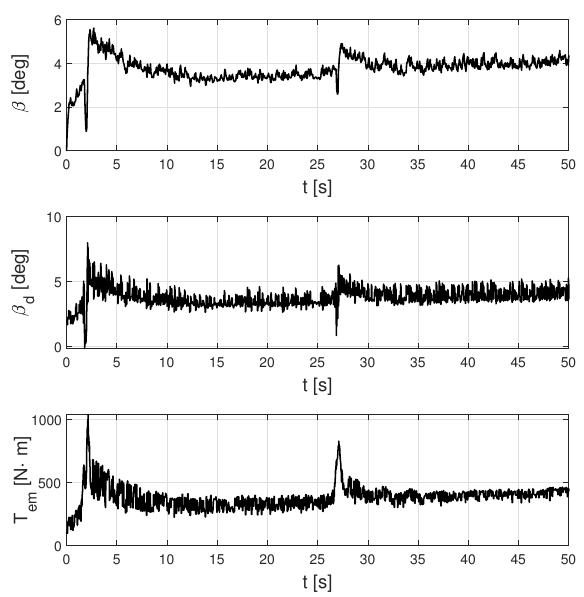
Figure 10. Blade pitch angle, desired blade pitch angle, and electromagnetic torque.